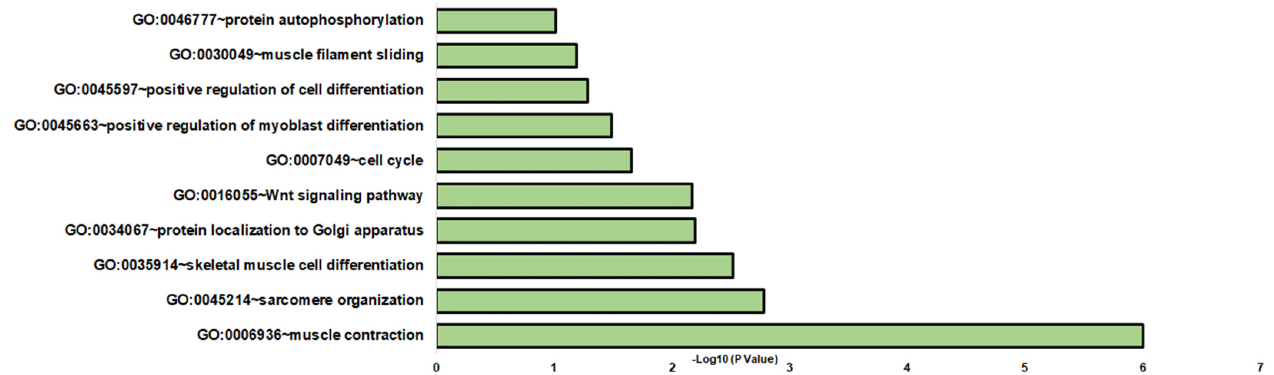
Figure 3. Gene enrichment analysis of biological processes in DOC and mifepristone plus DOC DETs. The graph indicates the − log 10 ( p -values) of enriched BPs of differentially expressed transcripts between the DOC and mifepristone plus DOC groups with p -values < 0.05.